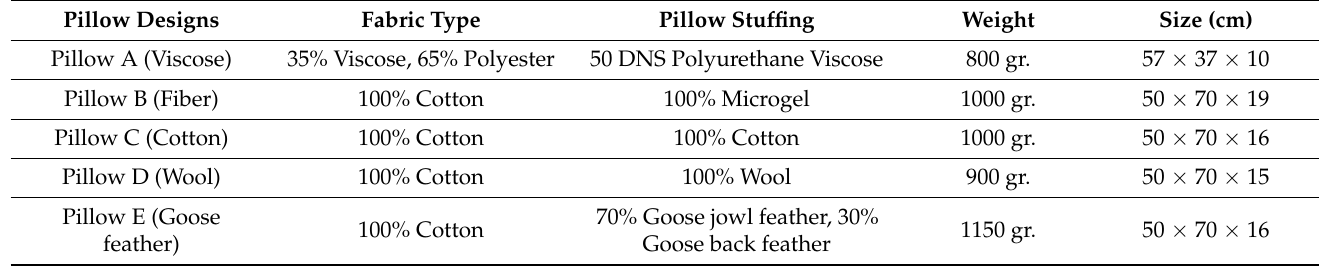
Figure 1. Forward head posture measurement.